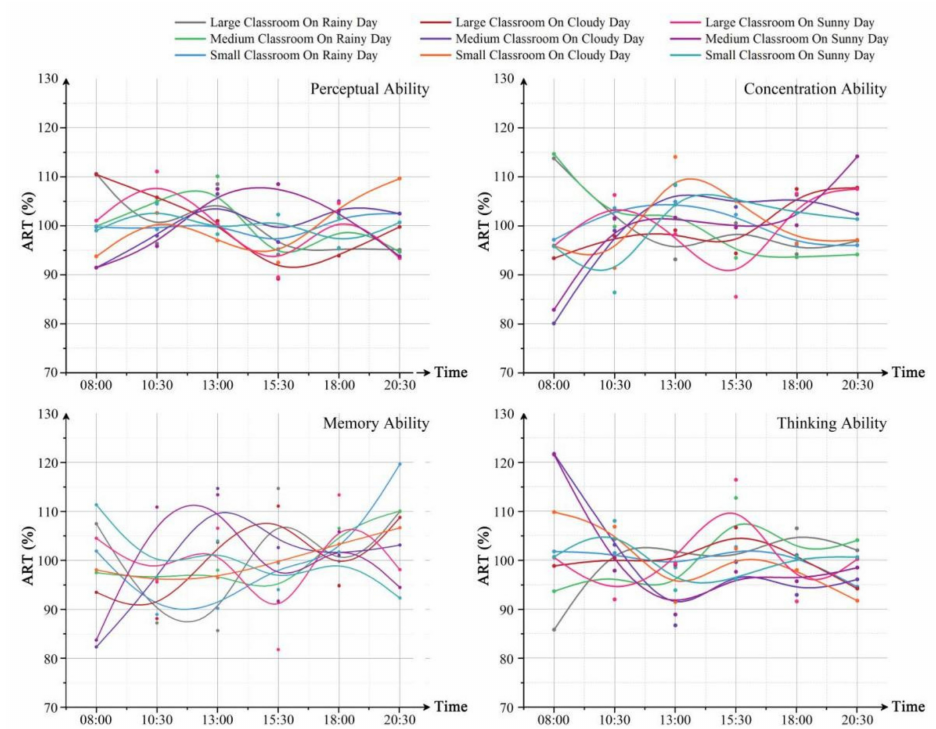
Figure 16. The ART of the four dimensions in the three types of classrooms under different weather conditions throughout the